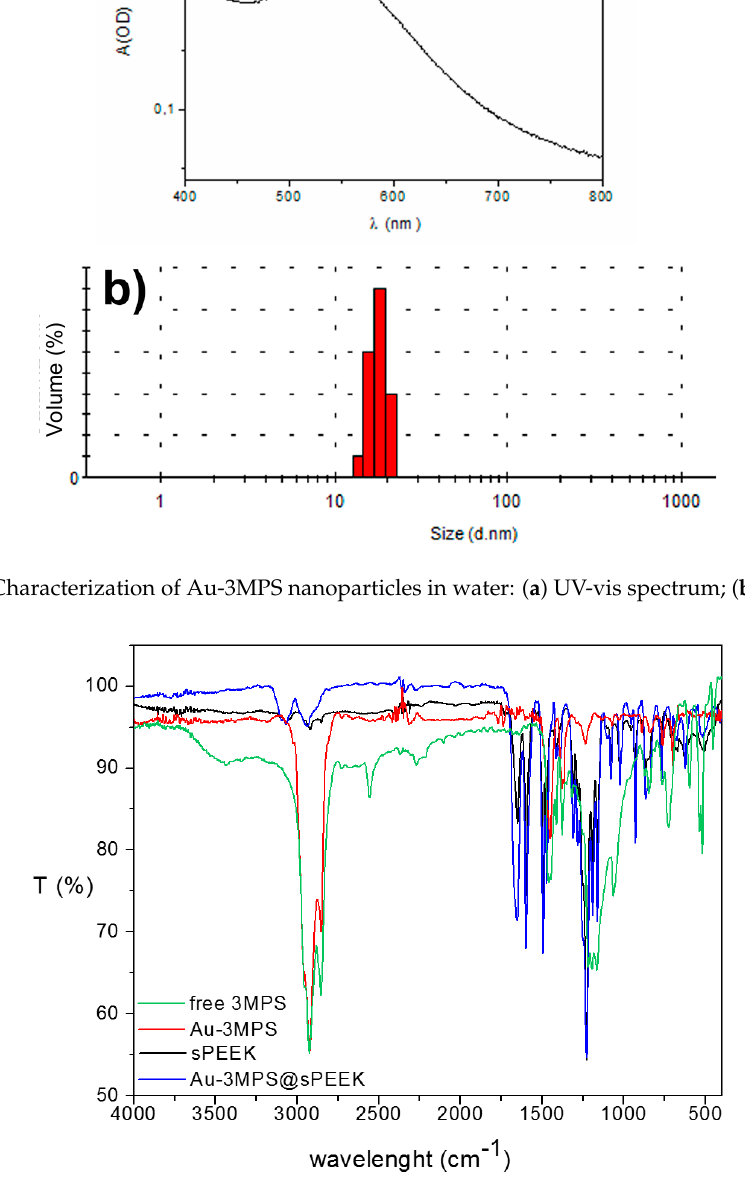
Figure 3. FTIR Transmission spectra of the nanocomposite Au-3MPS@sPEEK (blue line) compared with the sPEEK host membrane (black line), Au-3MPS NPs collected from the impregnation solution (red line), and free 3MPS thiol (green line).